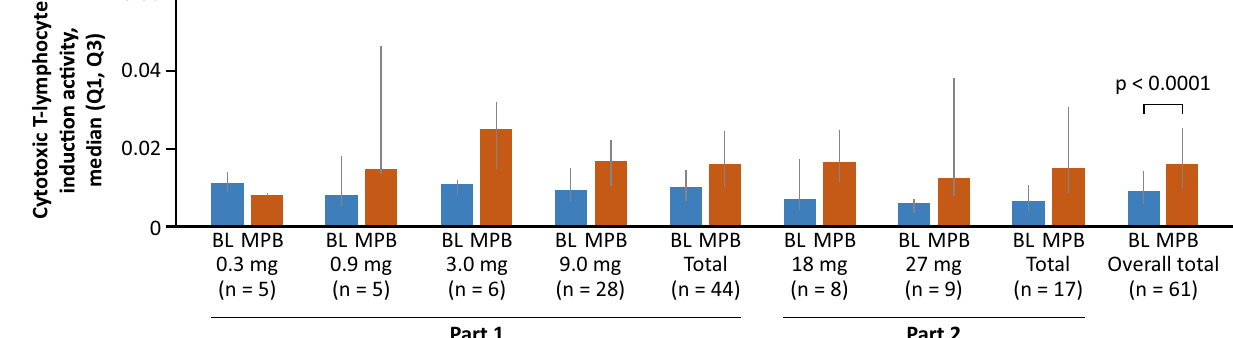
Figure 4. Baseline and post-baseline a CTL induction activity. All malignancy types combined. The CTLs in blood samples were measured by tetramer assay using flow cytometry; the evaluation of CTL induction is defined in the Efficacy assessments section of the Online Resource. P-values were calculated using the Wilcoxon signed-rank test (comparing post-baseline with baseline assessments). a Based on the mean of all post-baseline assessments of each patient. BL baseline, CTL cytotoxic T-lymphocyte, MPB mean of